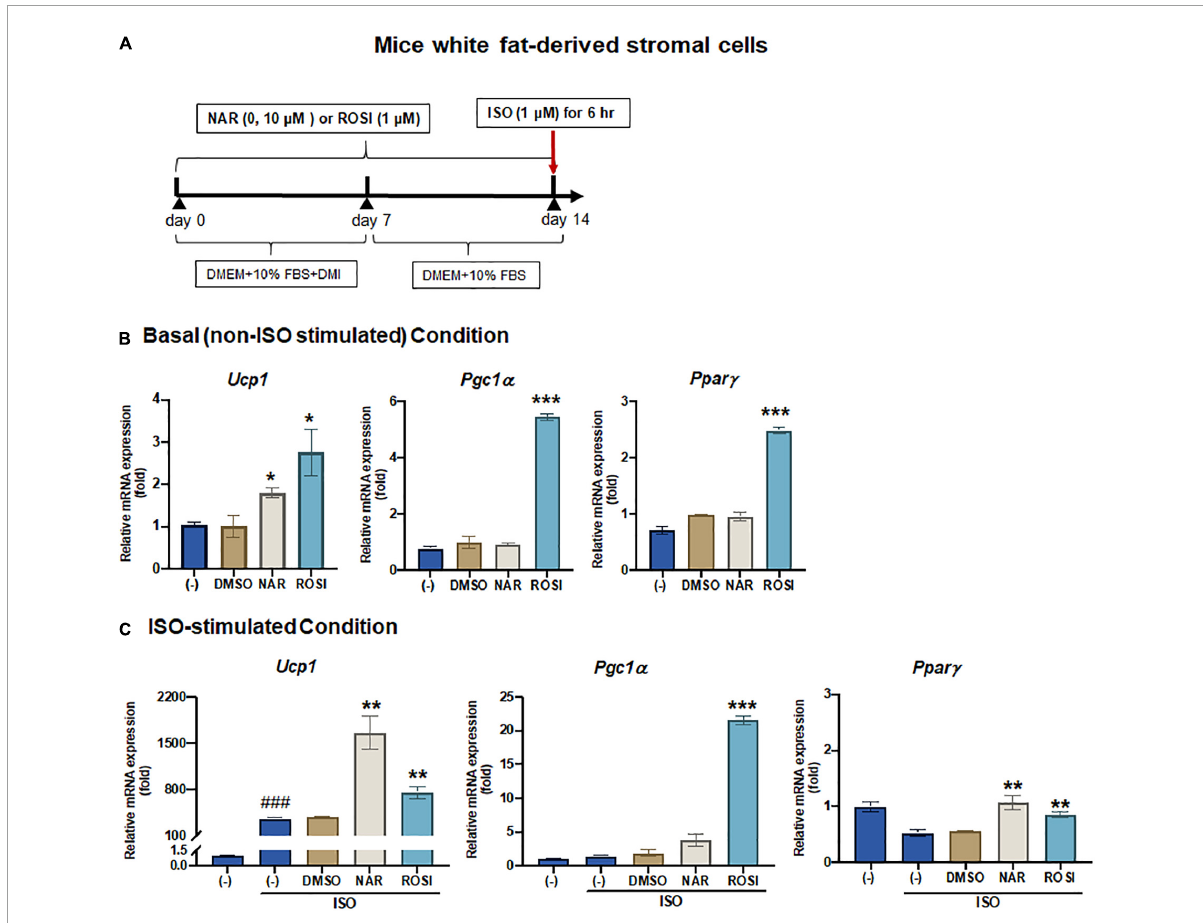
FIGURE2 Naringenin enhances basal and isoproterenol (ISO)-stimulated up-regulation of Ucp1 mRNA expression in primary white adipocytes differentiated from mice white fat-derived stromal cells. Mice white fat-derived primary stromal cells were induced to differentiate in the presence or absence of NAR (10 µ M) or ROSI (1 µ M) for 14 days. On day 14, the cells were stimulated with ISO (1 µ M) or the vehicle control for 6 h for mRNA analysis. (A) A diagram of the cell treatment and timeline. As described in the Materials and Methods, DMEM + 10% FBS + DMI refer to DMEM containing 10% FBS, 0.5 mM/L 3-isobutyl-1-methylxanthine, 1 µ M/L dexamethasone, and 10 µ g/mL insulin. DMEM + 10% FBS refer to DMEM containing 10% FBS. (B,C) Relative mRNA levels of Ucp1, Pgc1 α , and Ppar γ at the basal (B) and ISO-stimulated conditions (C) . mRNA expression is presented relatively to the loading control 36b4. Data = Mean ± SEM ( n = 3). *, **, *** p < 0.05, p < 0.01, and p < 0.001 compared to the DMSO samples, respectively (B,C) . ### p < 0.001 compared to the non-ISO stimulated (–) samples (C)